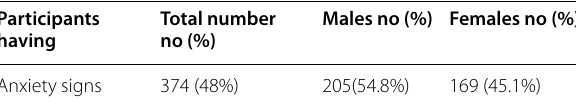
Table 3 Anxiety symptoms of